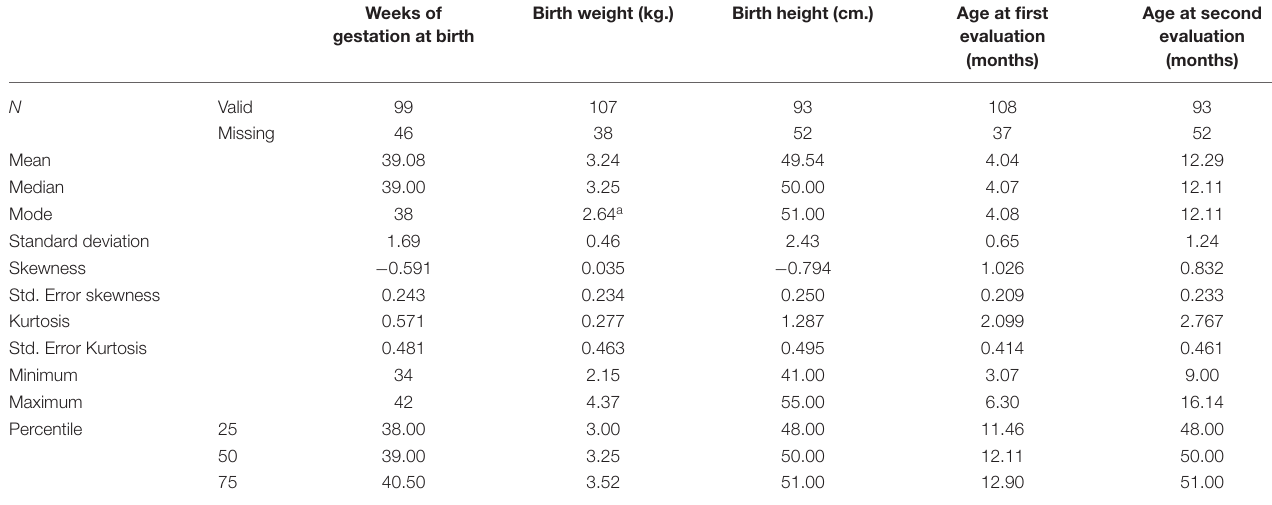
TABLE 1 | Main descriptive statistics of the characteristics of the infants participating ( n = 145).